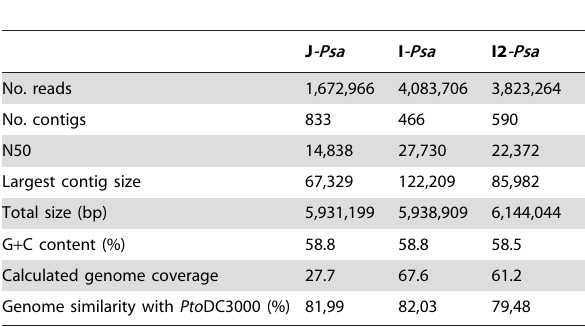
Table 1. General features for Pseudomonas syringae pv. actinidiae draft